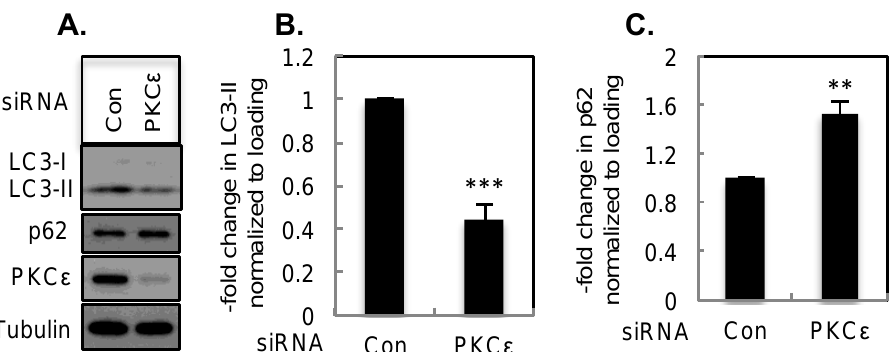
Figure 1. PKC ε knockdown inhibits basal autophagy. T47D cells were transfected with control Figure 1. PKCε knockdown inhibits basal autophagy. T47D cells were transfected with control non-targeting or PKC ε siRNA. ( A ) Western blot analysis was performed with indicated antibodies. non-targeting or PKCε siRNA. ( A ) Western blot analysis was performed with indicated antibodies. Tubulin was used to control for loading di ff erences. Bar graph represents mean ± S.E of LC3-II ( B ) and Tubulin was used to control for loading differences. Bar graph represents mean + S.E of LC3-II ( B ) p62 ( C ) from several independent experiments. ***, p ≤ 0.0005 ( n = 10); **, p ≤ 0.005 ( n = and p62 ( C ) from several independent experiments. ***, p < 0.0005 ( n = 10); **, p < 0.005 ( n = 7).